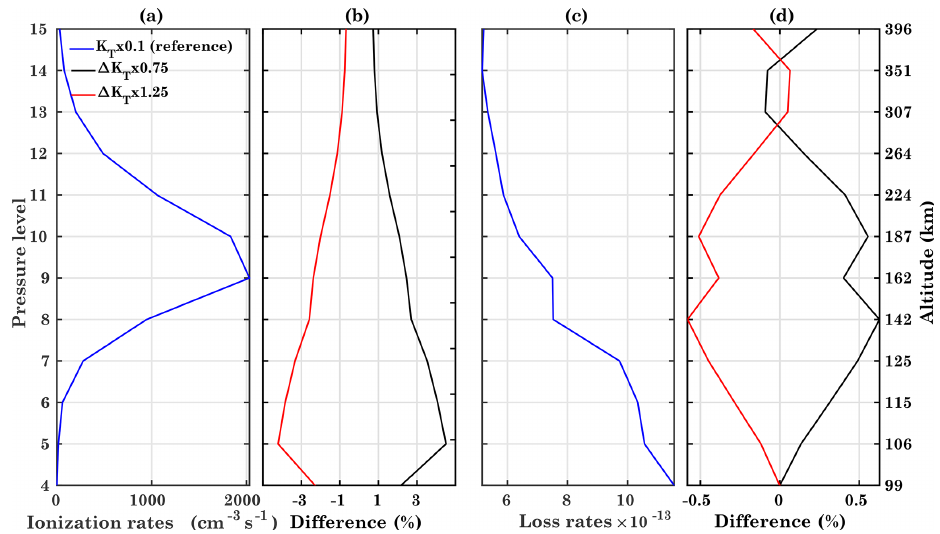
Figure 13. Atomic oxygen ionization (a) and loss rates (c) due to molecular nitrogen for the reference run K T × 1 . 0 and its difference (b, d) with K T × 0 . 75 and K T × 1 . 25 at different pressure levels on the 14th model day at geographic coordinates 40 ◦ N, 18 ◦ E.